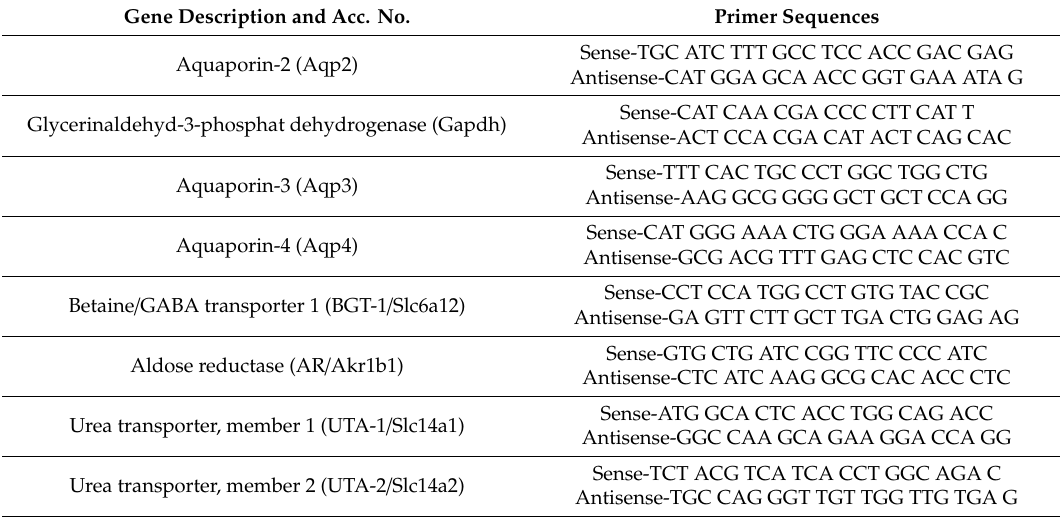
Table 1. Gene names, gene symbols, accession numbers, and primer sequences of genes used for real-time PCR. Gene Description and Acc.